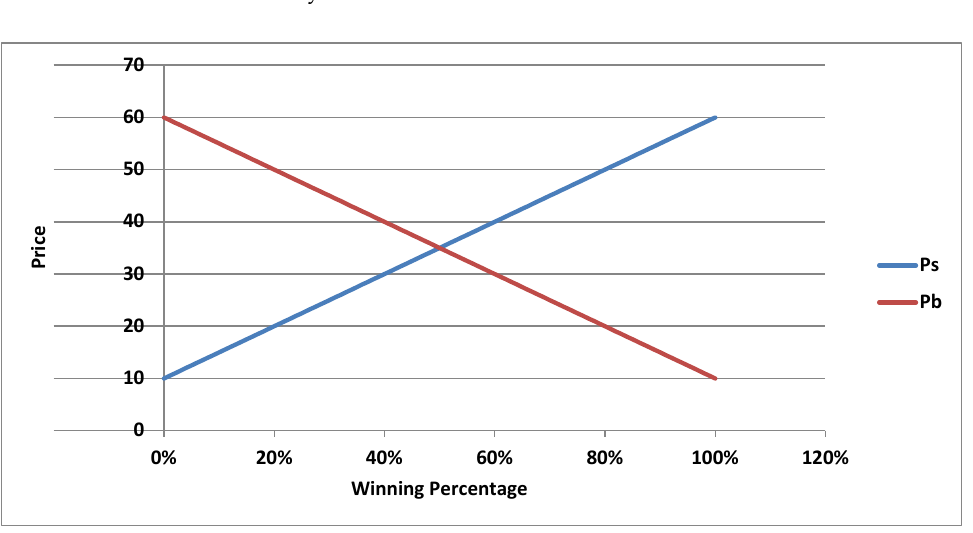
Figure 2. Illustration of the fuzzy win–win inverse functions (Equations (3) and (4)) based on the same example used in Figure 1, where CP = 10 and SP = 60 regardless of the